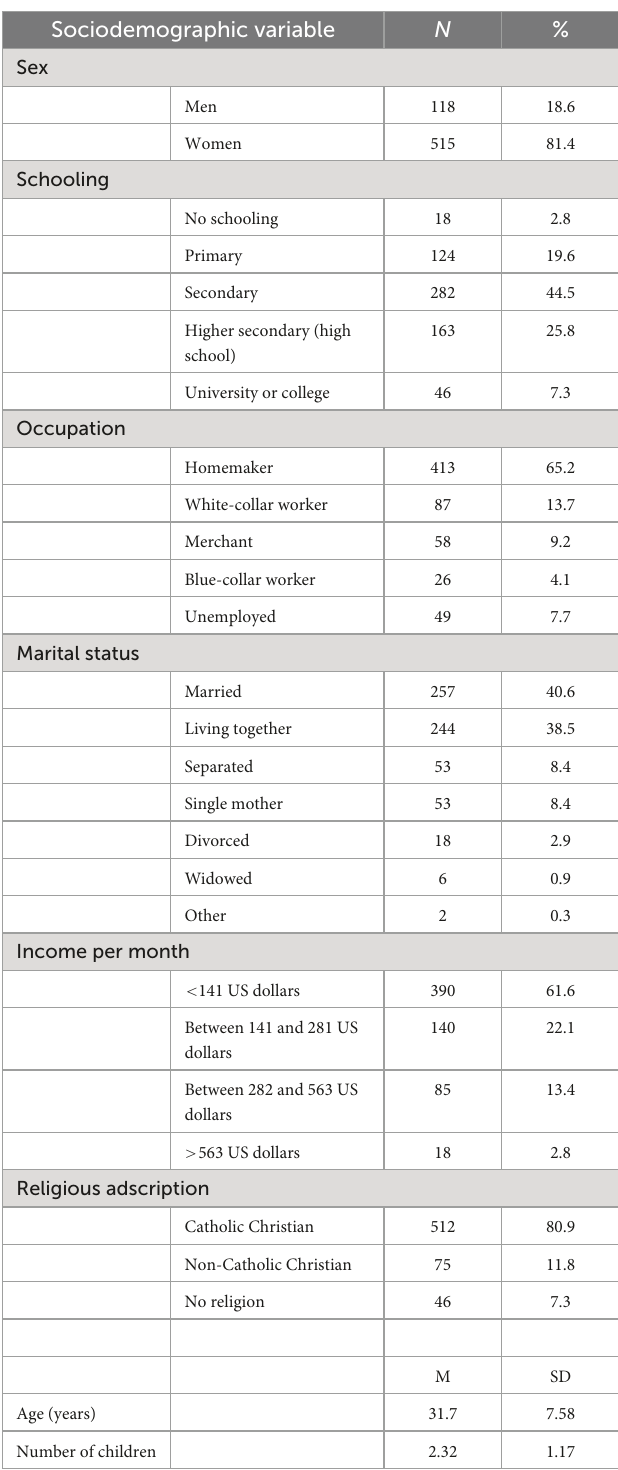
TABLE 1 Summary statistics of sociodemographic